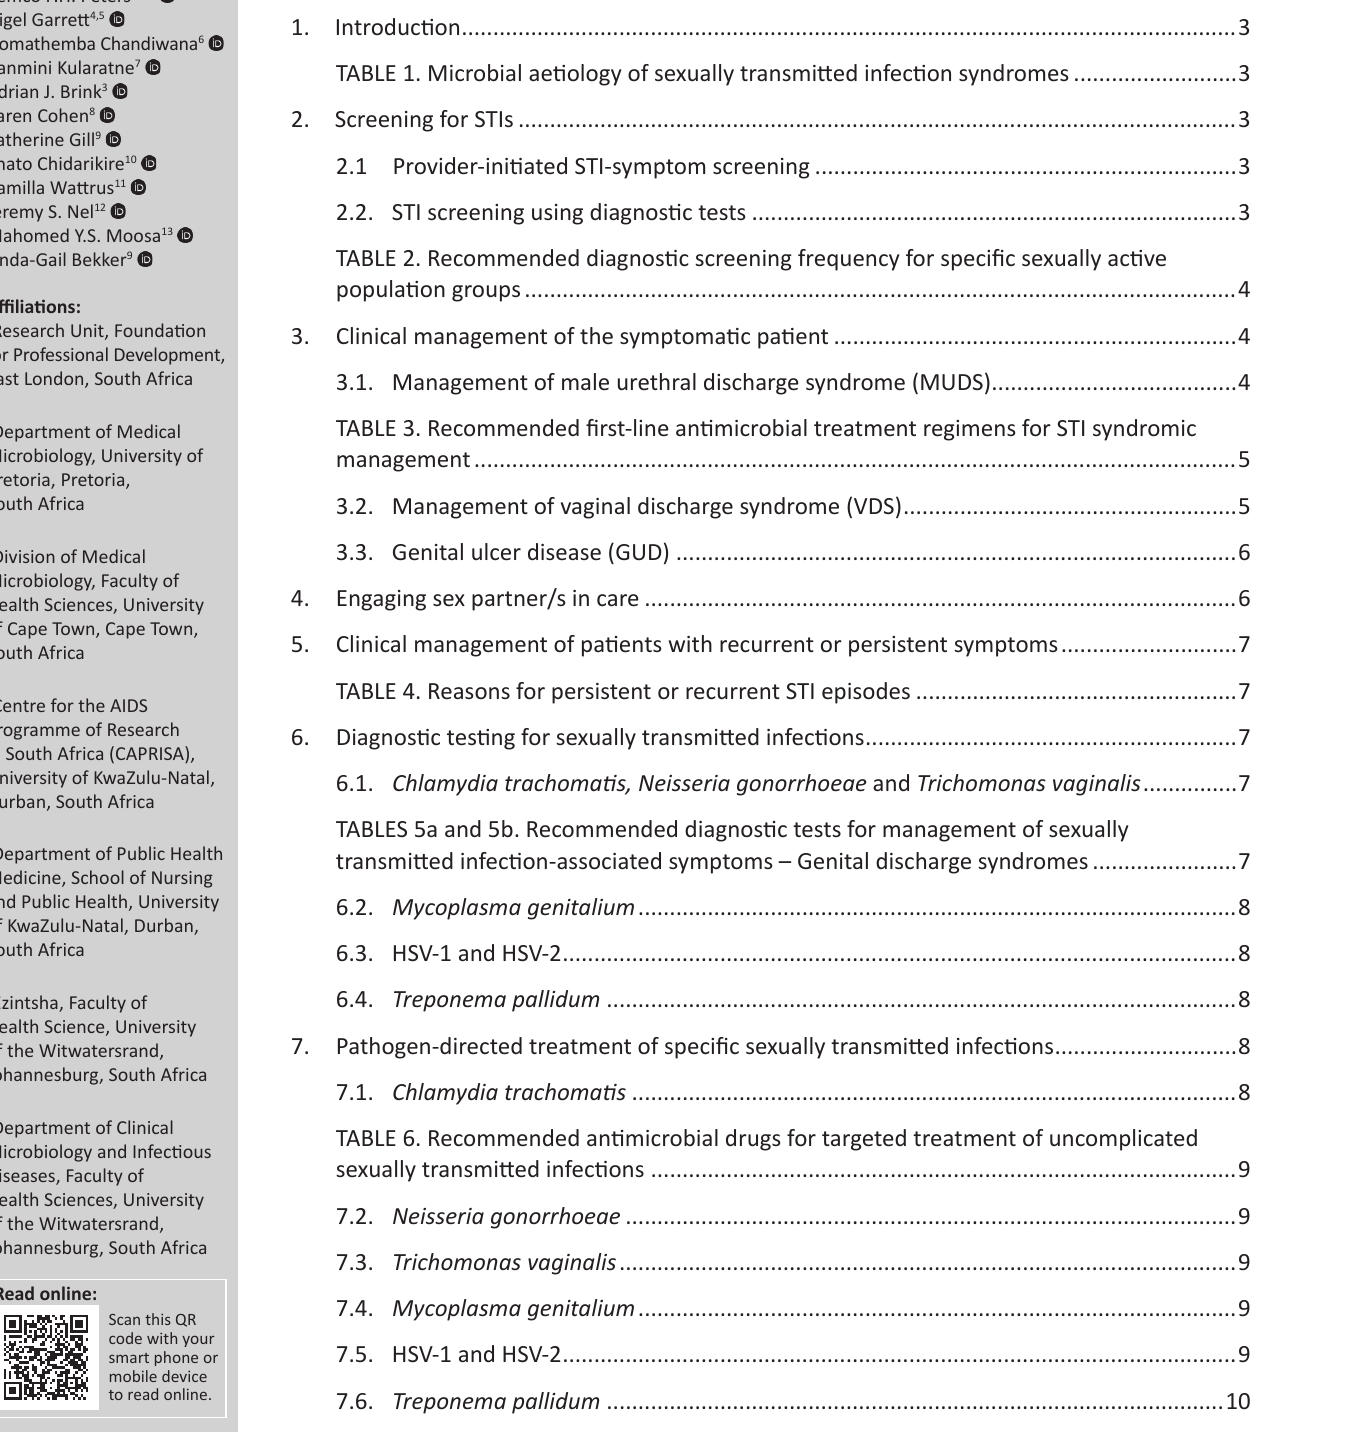
TABLE 2. Recommended diagnostic screening frequency for specific sexually active